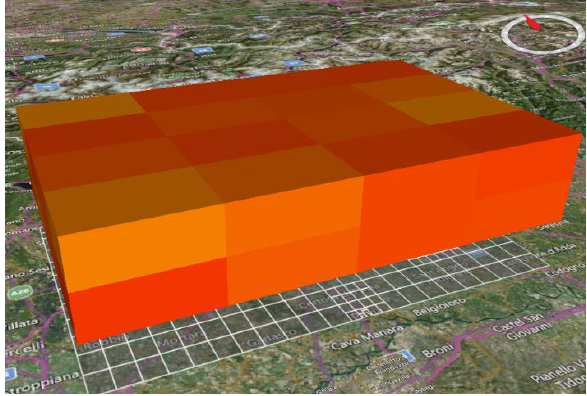
Figure 7. Group representation of average outgoing calls Moreover, performance improvements came in handy as